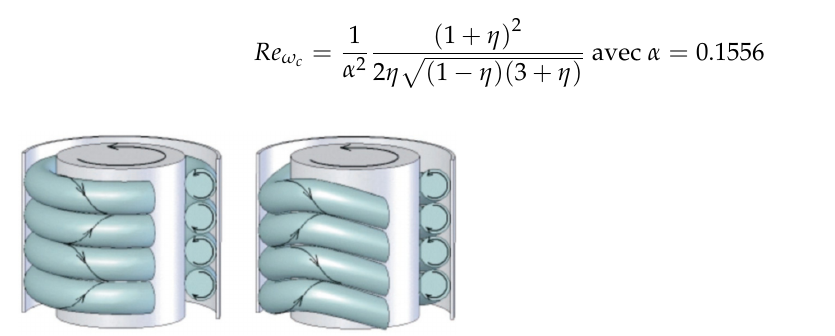
Figure 3. Taylor cells ( Left-hand ) and Wavy Taylor cell ( Right-hand )